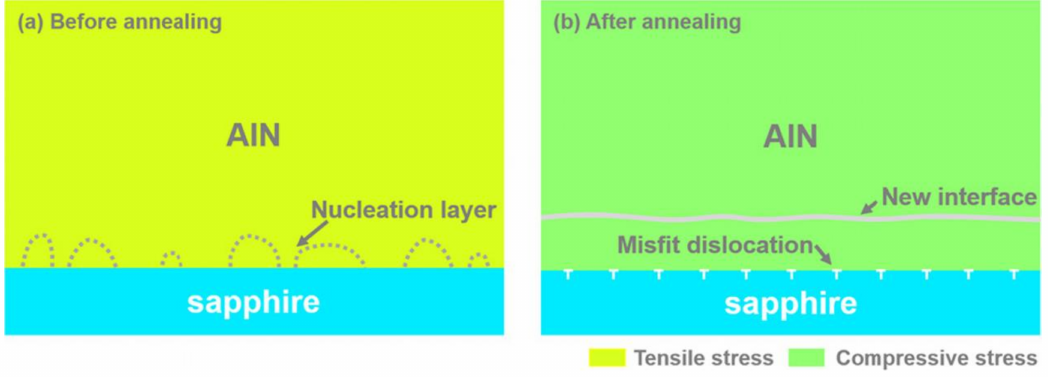
Figure 18. Cross-sectional schematic diagrams of AlN/sapphire template ( a ) before and ( b ) after HTA. After annealing, the grain boundaries disappear, and periodic misfit dislocations are generated on the AlN/sapphire interface. Reprinted from [82], with the permission of AIP